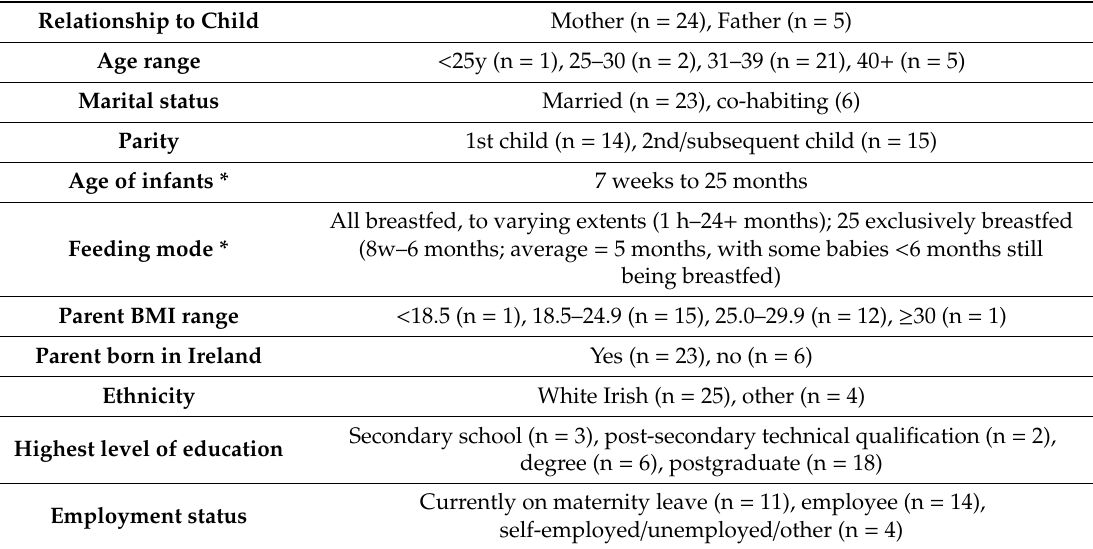
Table 1. Participant characteristics.